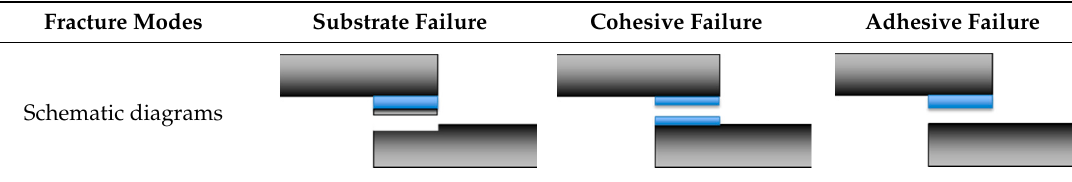
Table 4. Schematic diagram of fracture modes.